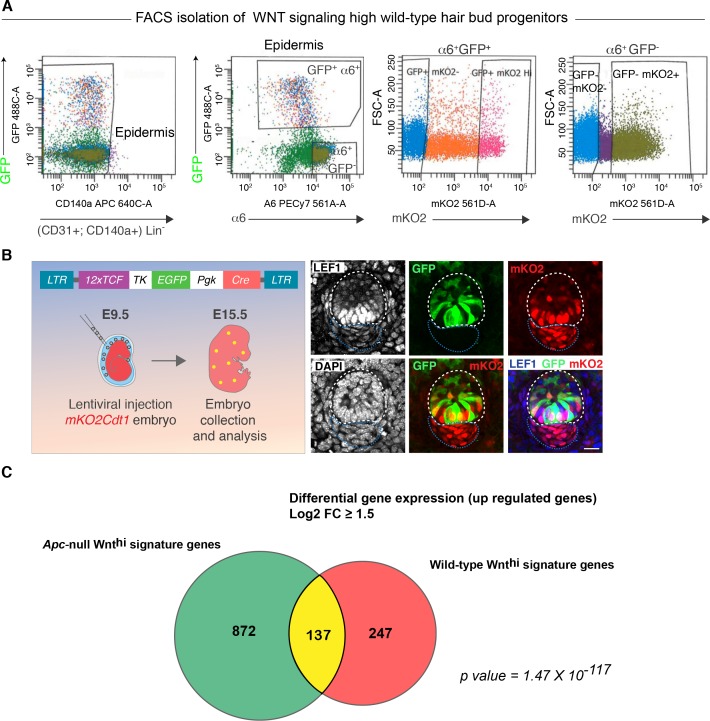
FACS purification strategy to isolate WNThi placode and WNTlo epidermal progenitors from wild-type embryonic skin.(A) FACS purification plots of single cell suspensions isolated from the dispase-selected epidermal/hair bud fraction of E17.5 skin. Pups were transgenic for Lhx2-GFP, active in basal hair bud progenitors, and for mKO2Cdt1, active in the slow-cycling basal skin progenitors of both hair buds and interfollicular epidermis. All basal progenitors are marked by α6 integrin. Non-epidermal cells (Lin-: CD131+ and CD140a+) were excluded by FACS. (B) mKO2Cdt1 embryos were exposed to lentivirus at E9.5 and analyzed at E15.5 as depicted in the schematic. The LV harbored a WNT-GFP reporter (12xTCF-TK-EGFP) and Pgk-Cre. Note that the progenitor cells from the developing hair follicle are concomitantly LEF1+, mKO2+ and WNT reporter positive. Scale bar, 20 μm. (C) Venn diagram depicts the overlap between Apc-null WNThi signature genes and wild-type (Lhx2GFP+ mKO2Cdt1+) WNThi signature genes. P values were calculated using the hyper geometric distribution formula via R. Note: While overlap was appreciable, WNThiApc-null transcripts were pure placode signature genes and in addition encoded cell cycle inhibitors, while wild-type WNThi cells included not only placode but also some bud mRNAs, and although slow-cycling, these cells were still proliferative.